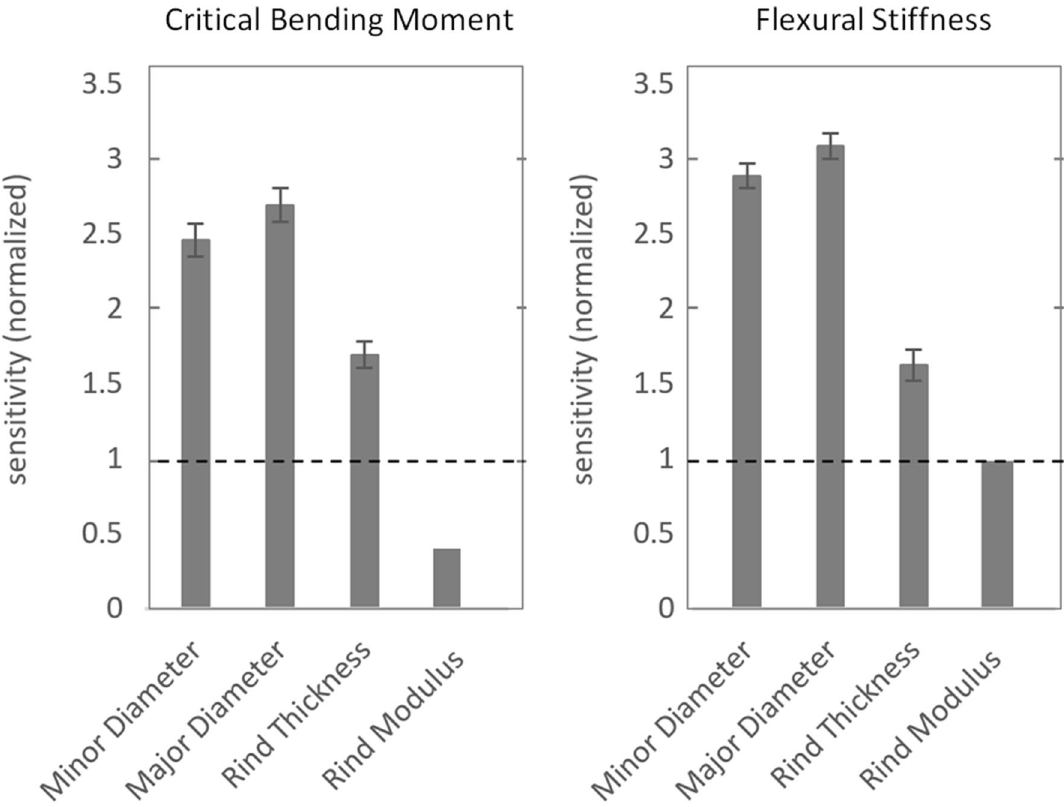
Figure 7. Empirical normalized sensitivity values Normalized univariate regression (n = 956) coefficients of geometric parameters for critical bending moment (left) and flexural stiffness (right), with 95% confidence intervals on the regression coefficients, compared with finite element geometric sensitivities.